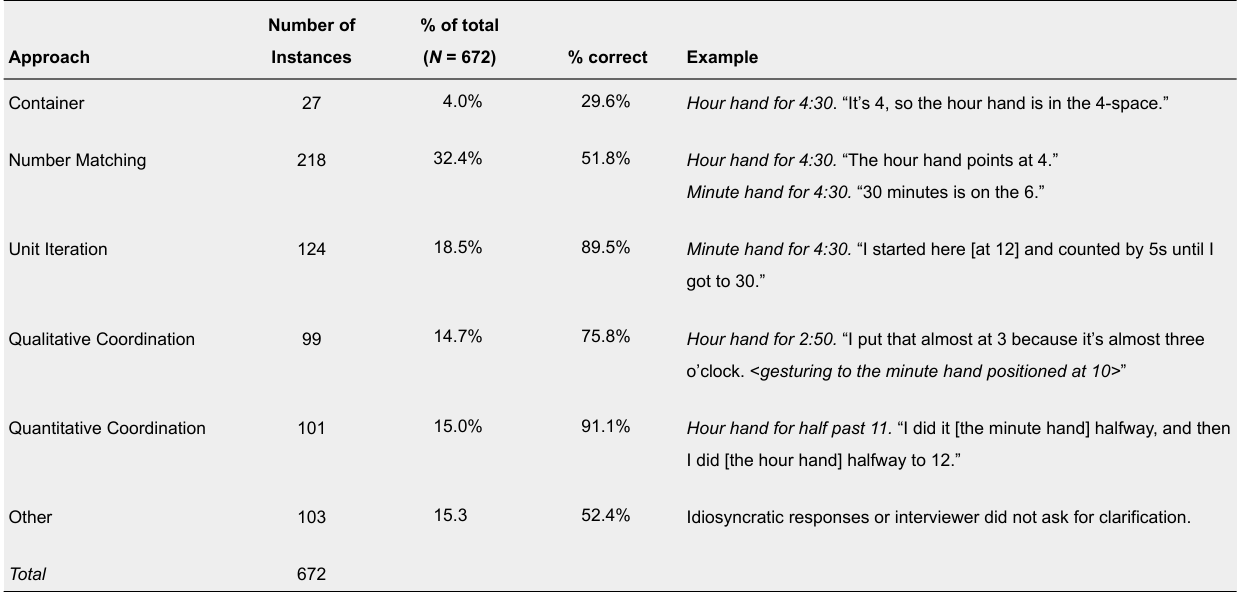
Results of Coding for Students’ Solution